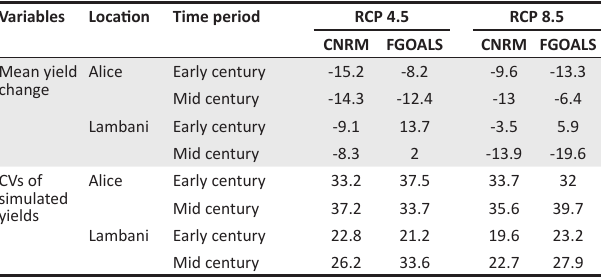
TABLE 3: Simulated mean maize-yield changes and coefficients of